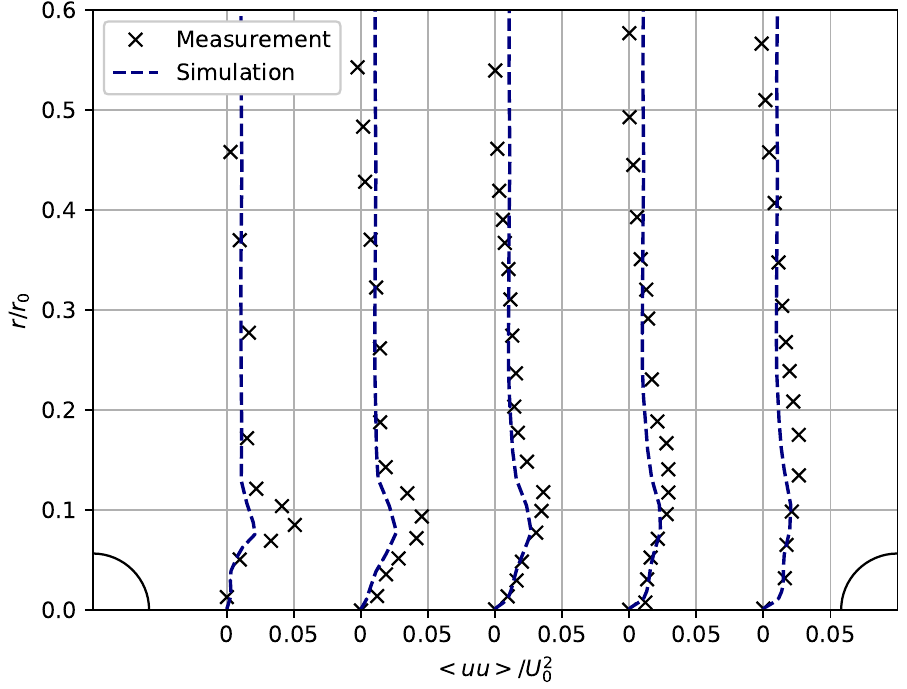
Figure 7. Comparison between measurement and simulation with the velocity variations < uu >.